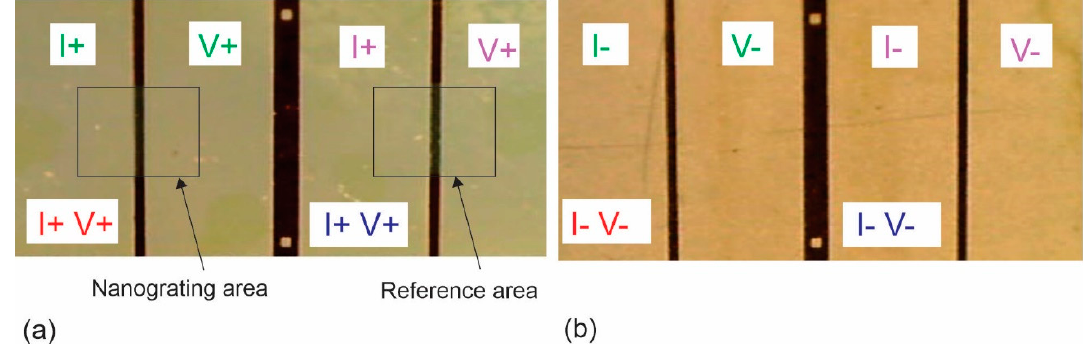
Figure 3. ( a ) Front side metal contact layout. Nanograting is fabricated inside the window opened in SiO 2 layer. ( b ) Back side contact layout.